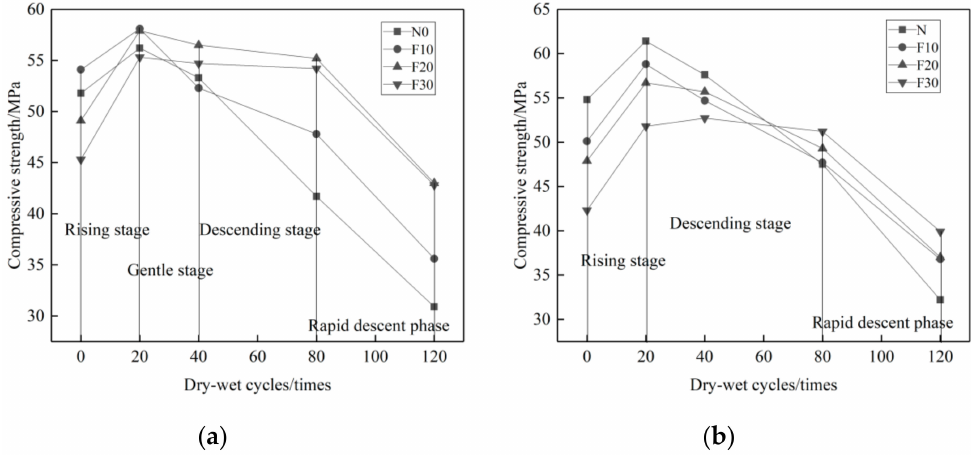
Figure 9. Variation curve of compressive strength of UFA concrete with different erosion times under different erosion conditions. ( a ) 10% Na 2 SO 4 , ( b ) 10% MgSO 4